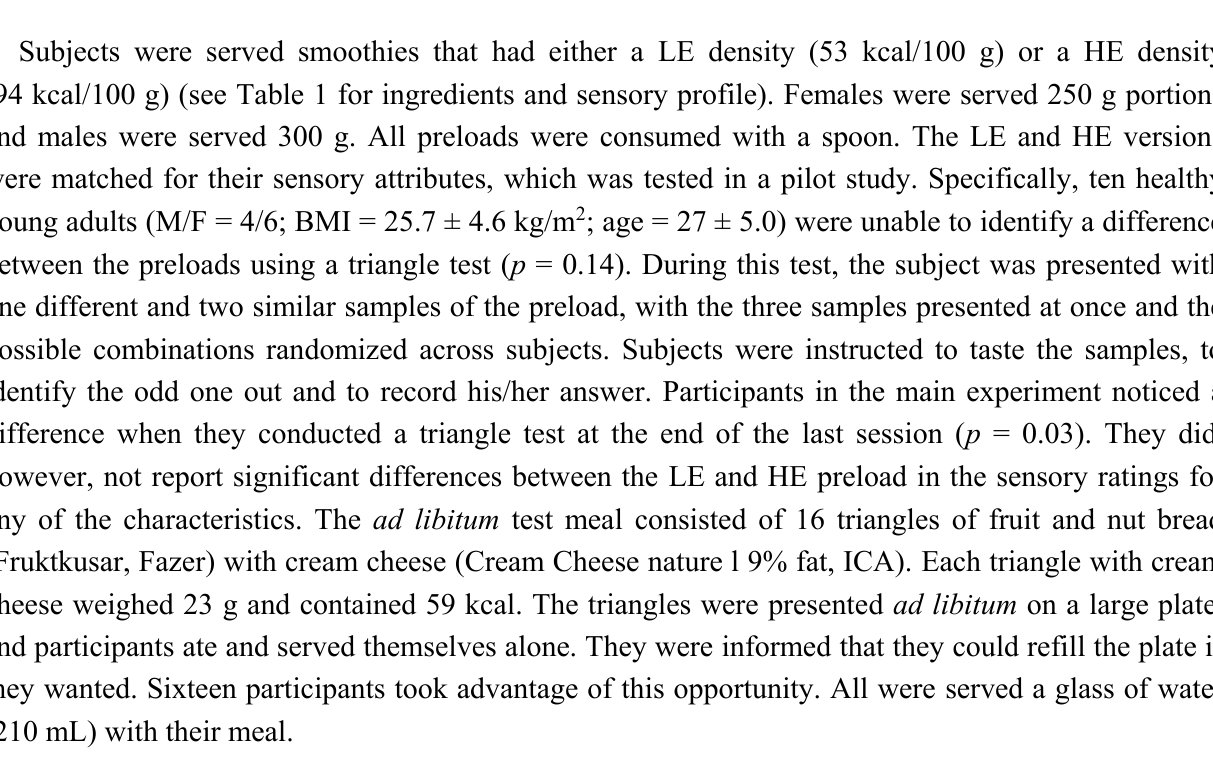
Table 1. Ingredients, sensory profile and liking ratings (mean ± SD) of the preloads served in the experiment ( n =